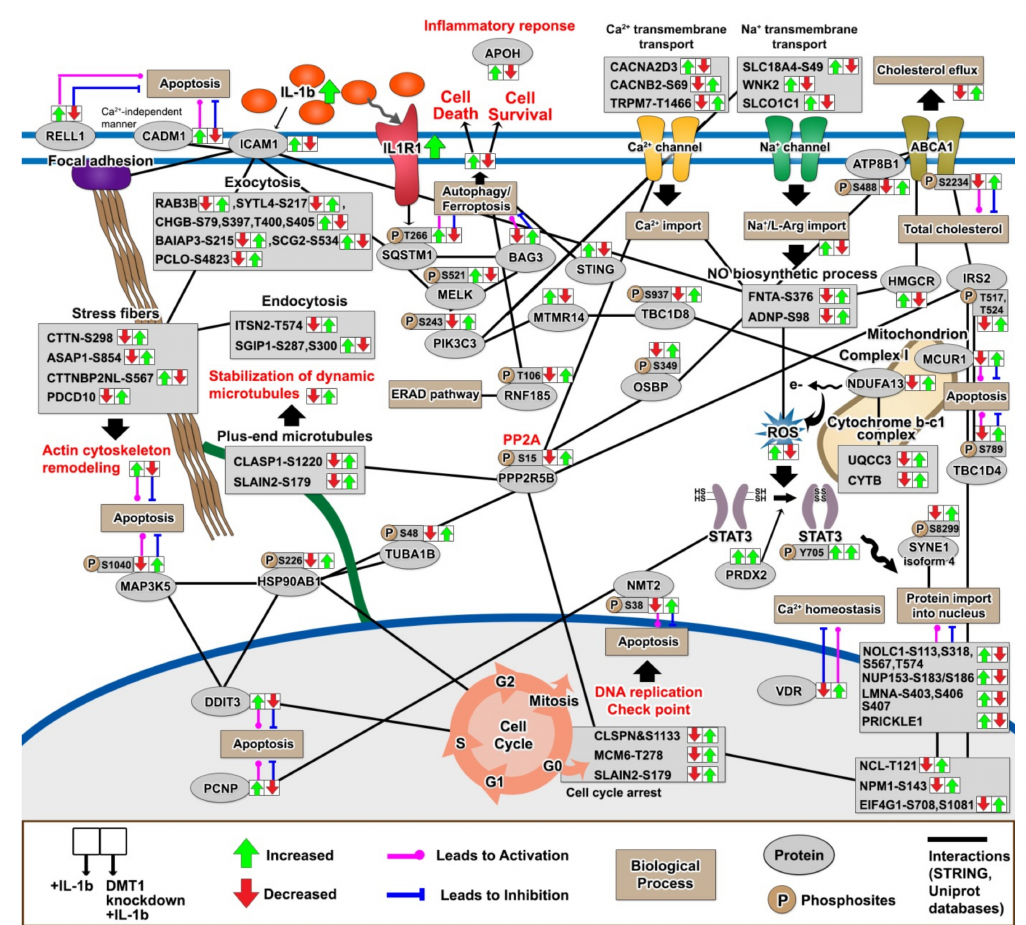
Figure 6. Schematic overview of potential protective proteins associated with anti-apoptosis or anti-inflammation in DMT1 -silenced β -cells against pro-inflammatory attack. (Green: significantly increased, Red: significantly